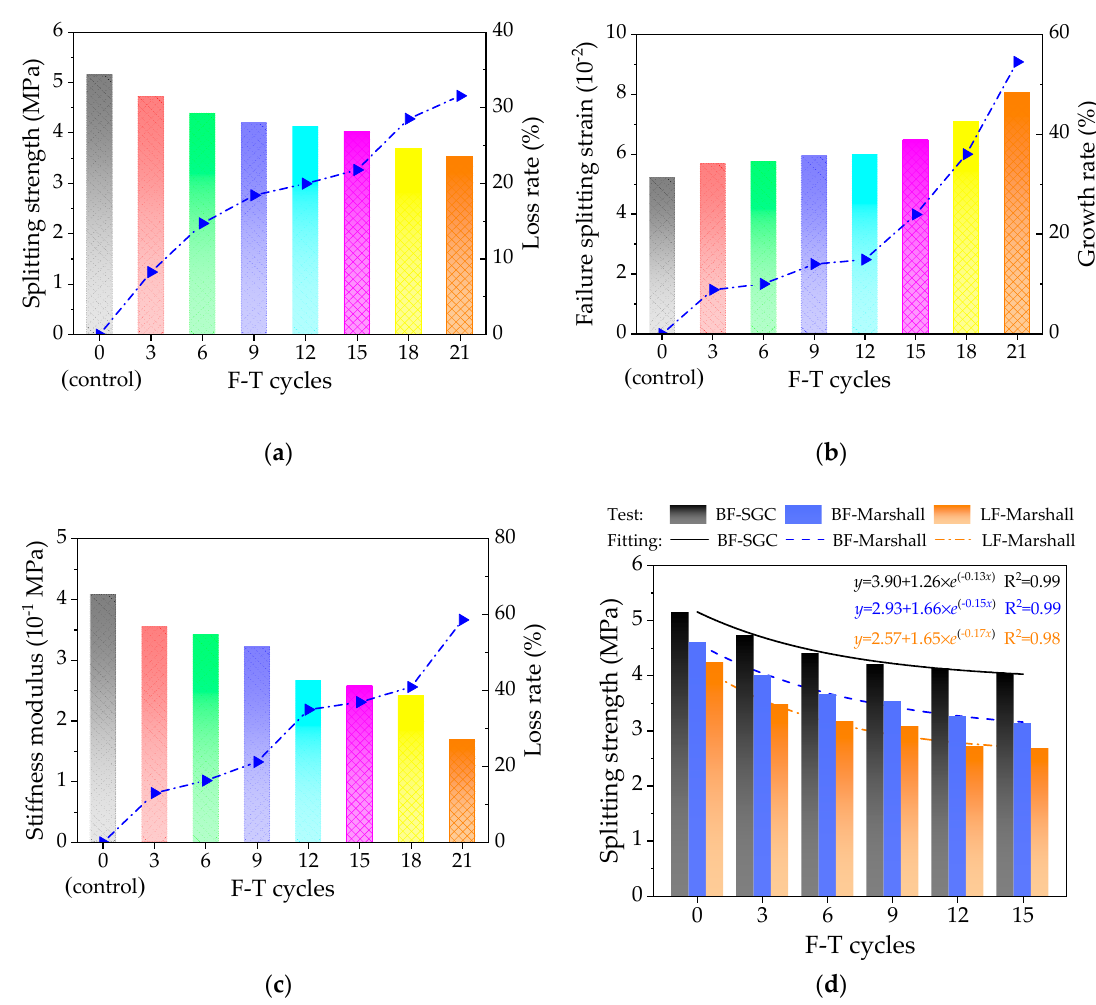
Figure 7. The low-temperature splitting tensile results: ( a ) splitting strength, ( b ) failure strain, and ( c ) splitting failure stiffness modulus, ( d ) comparative results.